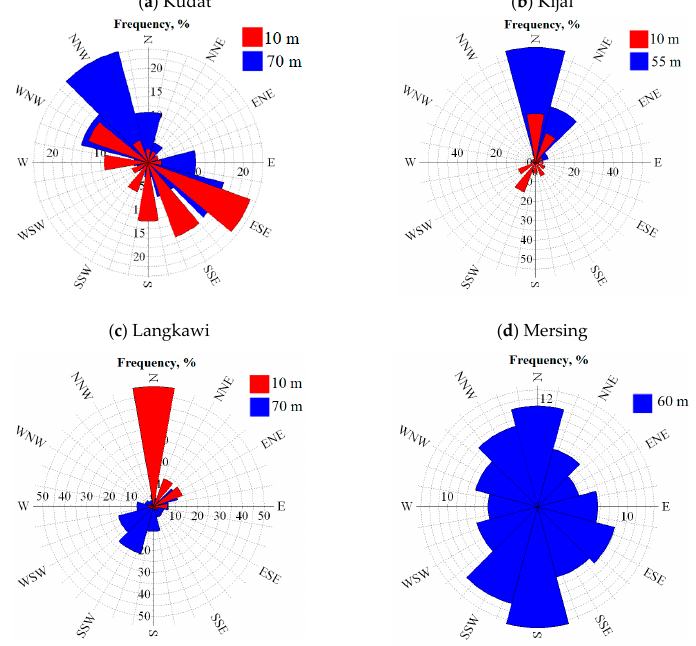
Figure 6. The wind rose for every selected site ( a ) Kudat; ( b ) Kijal; ( c ) Langkawi; ( d ) Mersing.